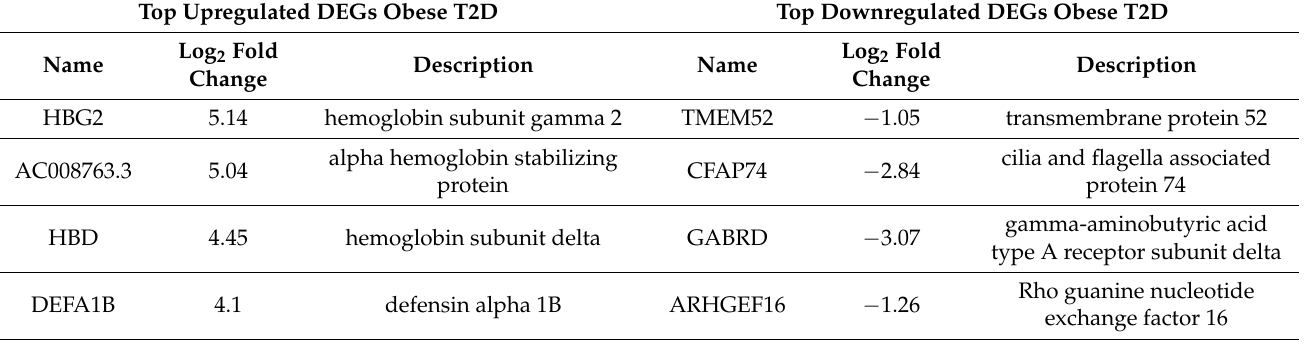
Table 2. Top 20 DEGs in obese